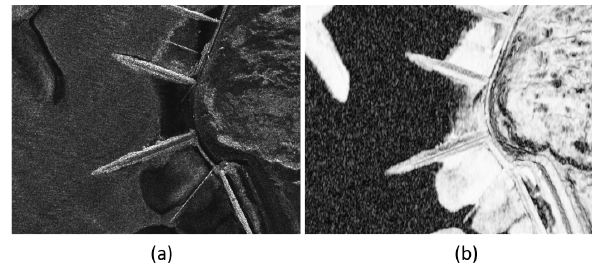
Figure 5. Distinguishing features for the generation of WLB: In (a) S-band VV amplitude (Master) and in (c) interferometric coherence (S-band, VV) is